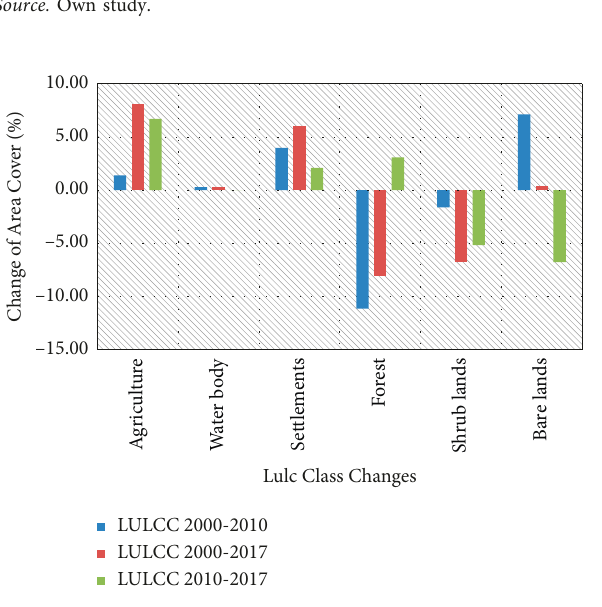
Figure 6: Percentage distributions of land cover changes from 2000 to 2017. Source. Own